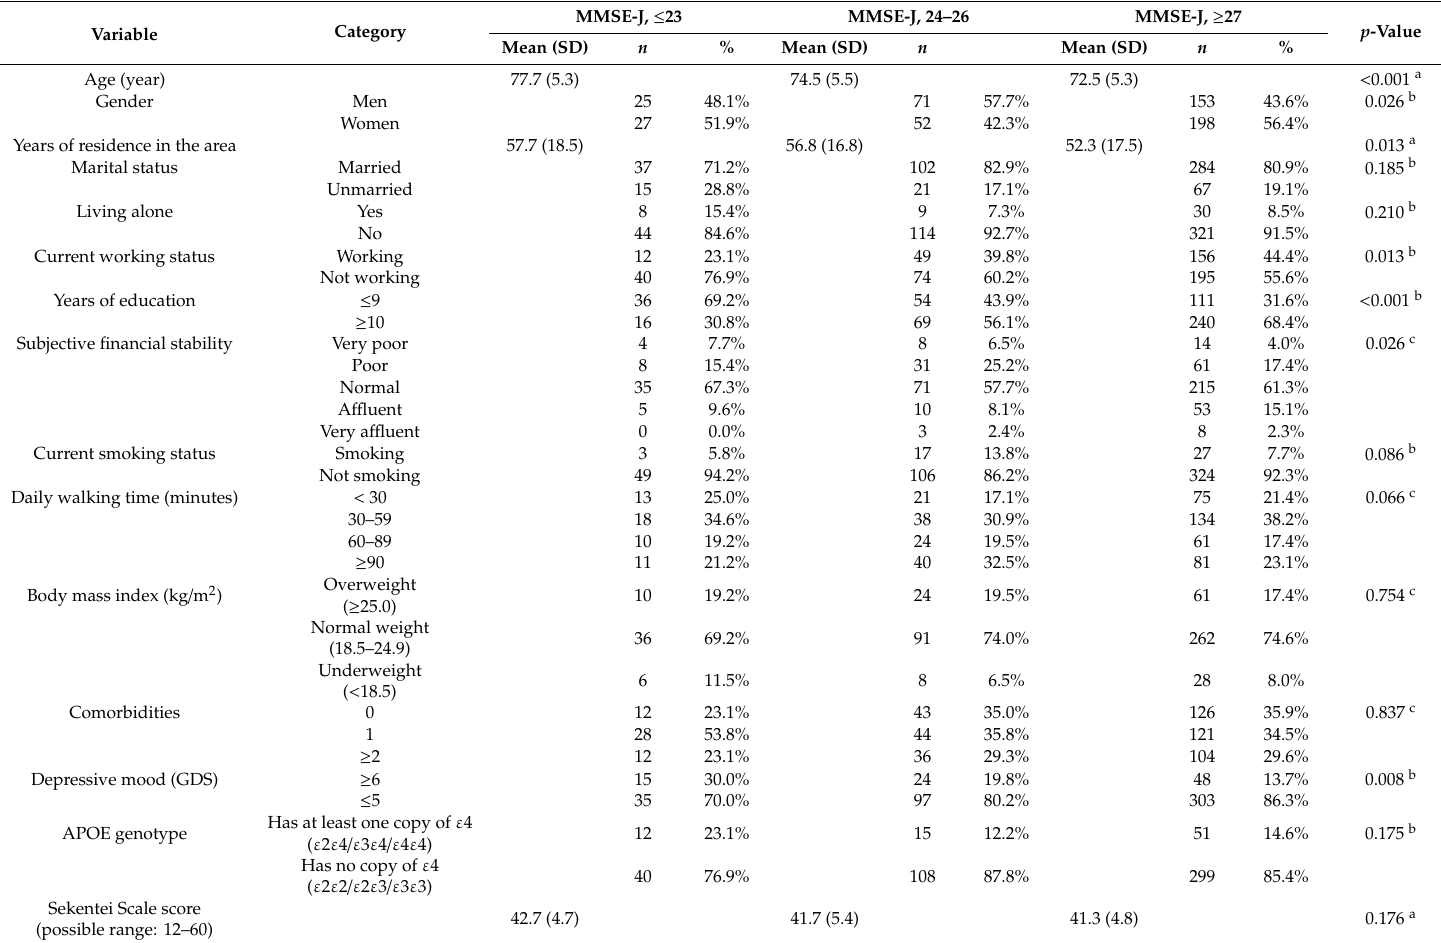
Table 2. Comparison of participants’ characteristics by cognitive